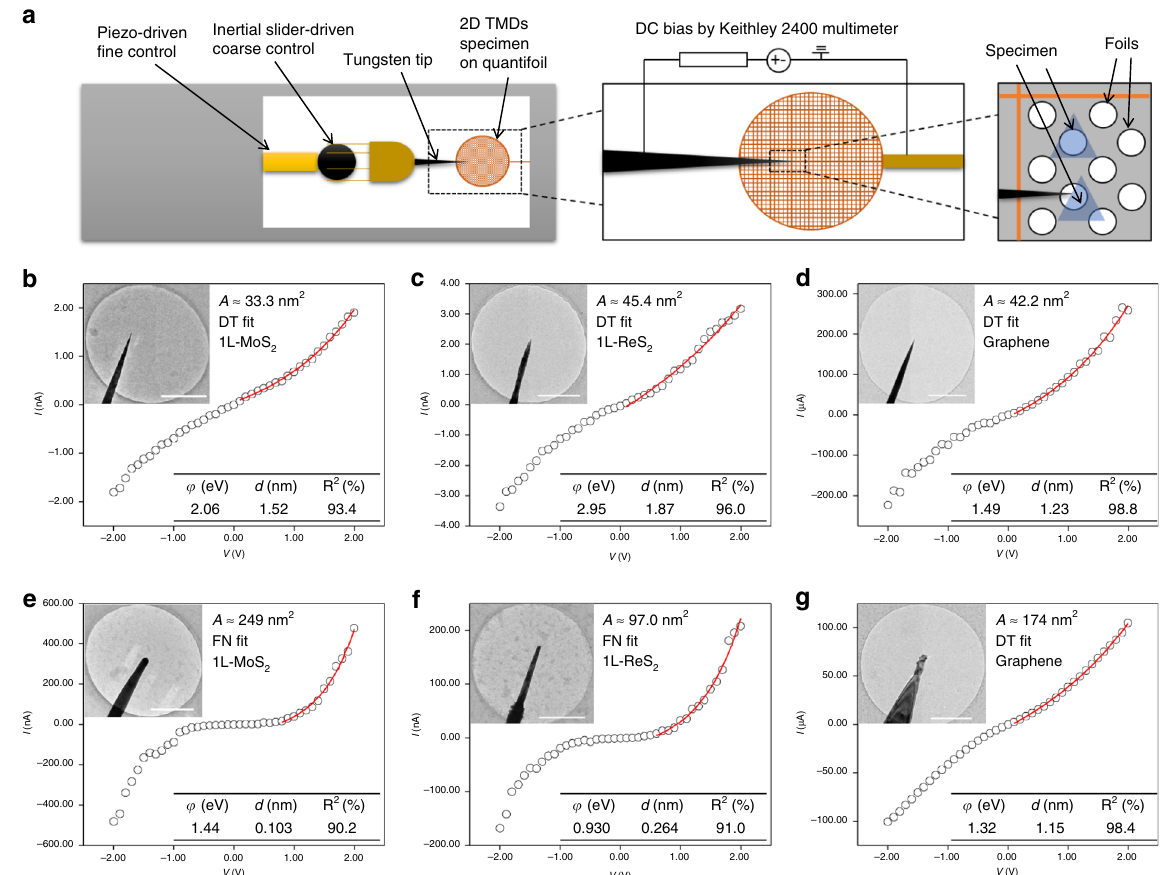
Fig. 1 Current – voltage measurements of the W-CVD grown 2D material contacts. a Schematic of experimental setup. b – d I – V measurements of CVD grown MoS 2 , ReS 2 , and graphene monolayer with small ( A < 50 nm 2 ) W probes, respectively. The inset show TEM images of the contact morphology and scale bars = 0.5 µ m. The measured contact area ( A ), fi tting model and the fi tting parameters are also shown. The solid lines indicate the fi tted range. e – g I – V measurements of CVD grown MoS 2 , ReS 2 , and graphene monolayer with large ( A > 95 nm 2 ) W probes, with inset TEM images of the contact morphology, scale bars = 0.5 µ m. The complete fi tting curves can be seen in Supplementary Fig.